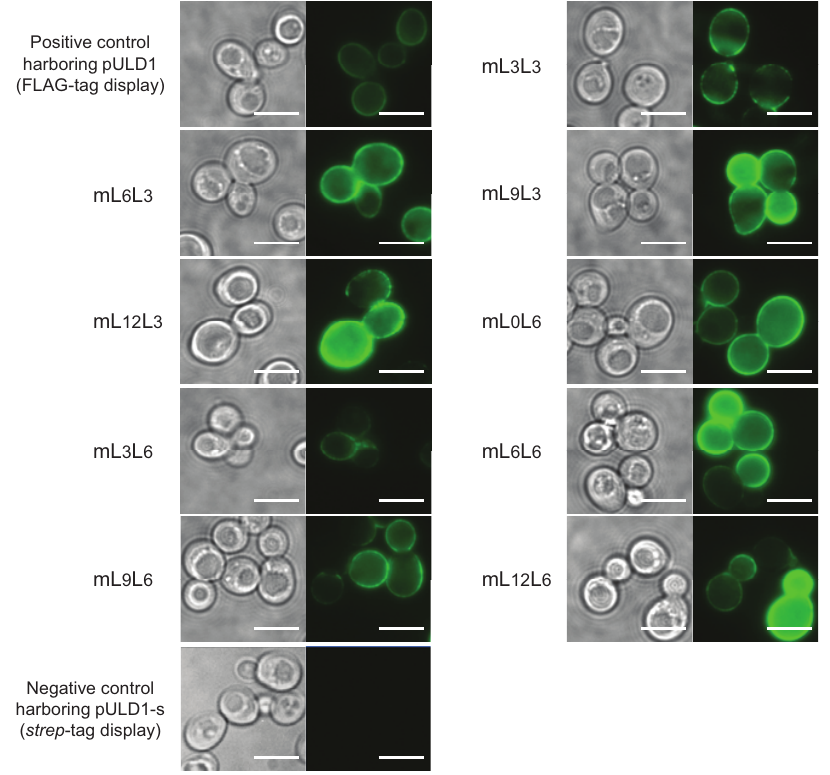
Figure 2. Immunofluorescent labeling of tandemly fused MBDs of NikRm displayed on the yeast cell surface using anti-FLAG antibody and Alexa Fluor 488 goat anti-mouse IgG antibody. Phase-contrast micrographs ( left ) and immunofluorescence micrographs ( right ). Yeast mL X L Y is the constructed strain harboring pULD1-mL X L Y , where X and Y represent the amino-acid lengths of linkers 1 and 2, respectively. The scale bar indicates 5